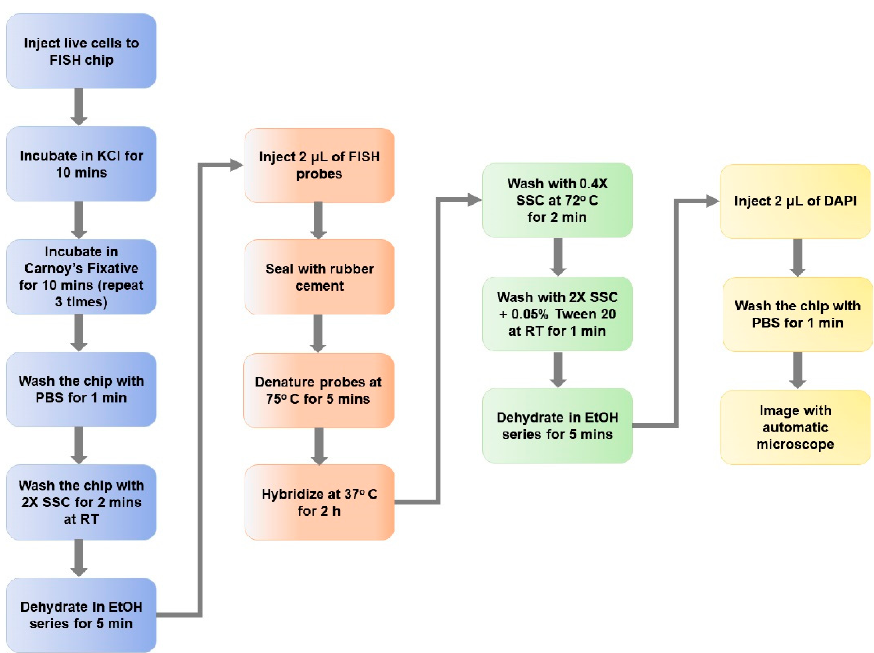
Figure 5. Workflow of FISH using the microtrap device. The workload was reduced from 2 days (slide method) to 4 h using the microtrap device primarily due to the hybridization time reduced from overnight to 2 h. The probe volume required for the assay was also reduced from 10 to 2 µ L as well as using the microtrap device. Live cells were injected into the microtrap device at a flow rate of 10 µ L / min and the washing steps were done at 5 µ L / min to reduce the shear stress on the fixed cells contained within the microfluidic